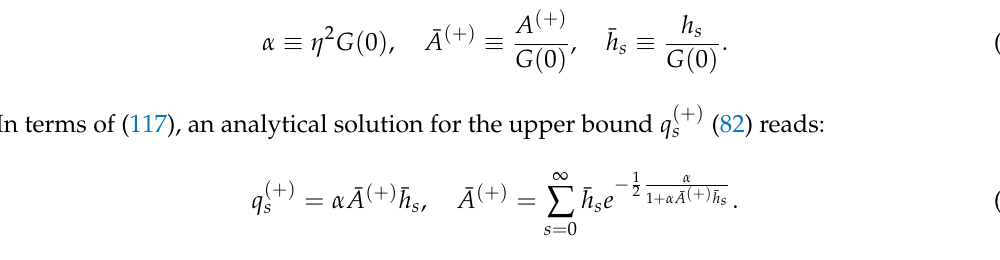
Figure 4. Dependence of the majorant F sep on the amplitude of the coupling constant g ( 0 ) for different values of ε . The width parameter w = 100, the propagator amplitude D ( 0 ) = 1 (which demonstrates the dynamics with respect to the value g ( 0 )